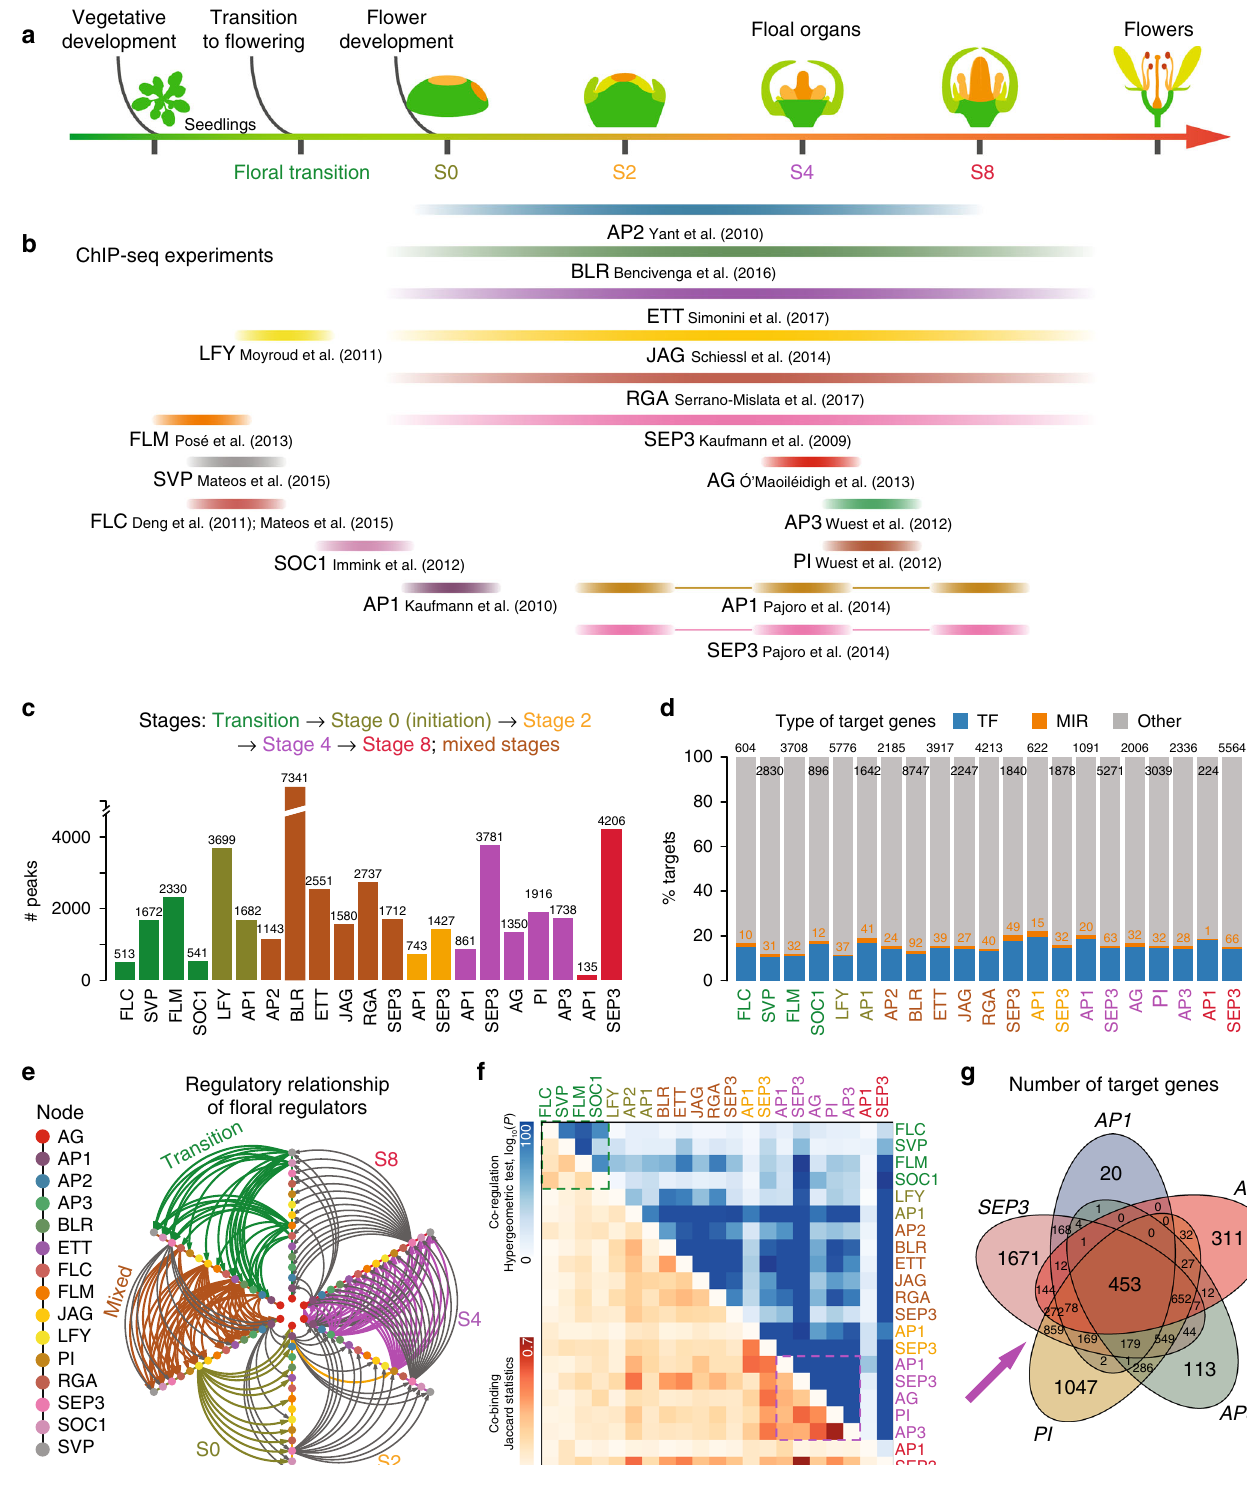
signi fi cant binding sites across fl ower developmental stages, in agreement with its roles during fl oral organ development and with its expression levels (Fig. 1c). On the other hand, AP1 loses binding sites during the developmental time-course, consistent with its important role as FM identity factor at early stages of fl ower development, and a more restricted expression at later time points (reducing the ChIP ef fi ciency).